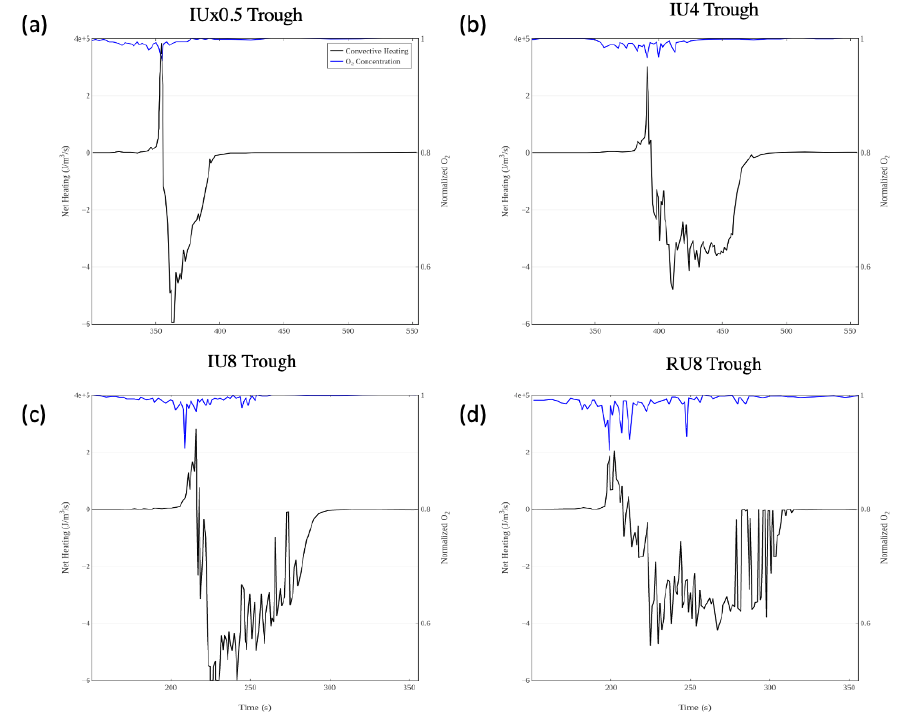
Figure 7. Non-stationary trough plots of oxygen concentration (blue lines) and convective heat flux to the fuels (black lines). Panel titles indicate the simulation cases being depicted. ( a ) IUx0.5 Trough ( b ) IU4 Trough ( c ) IU8 Trough ( d ) RU8